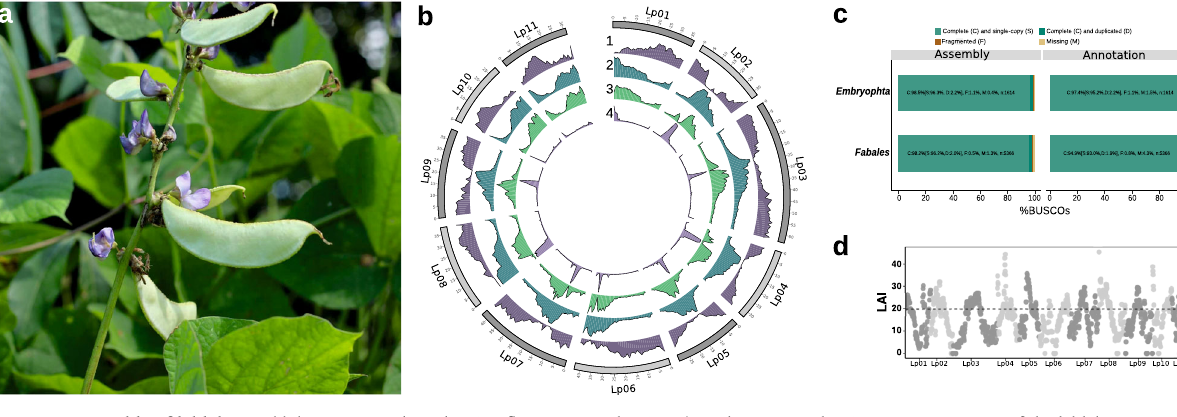
density, 4) tandem repeat density. c BUSCO scores of the lablab genome and gene annotation using the embryophyta and fabales reference lineages. d LAI index of the 11 lablab chromosomes. Source data are provided as a Source Data fi